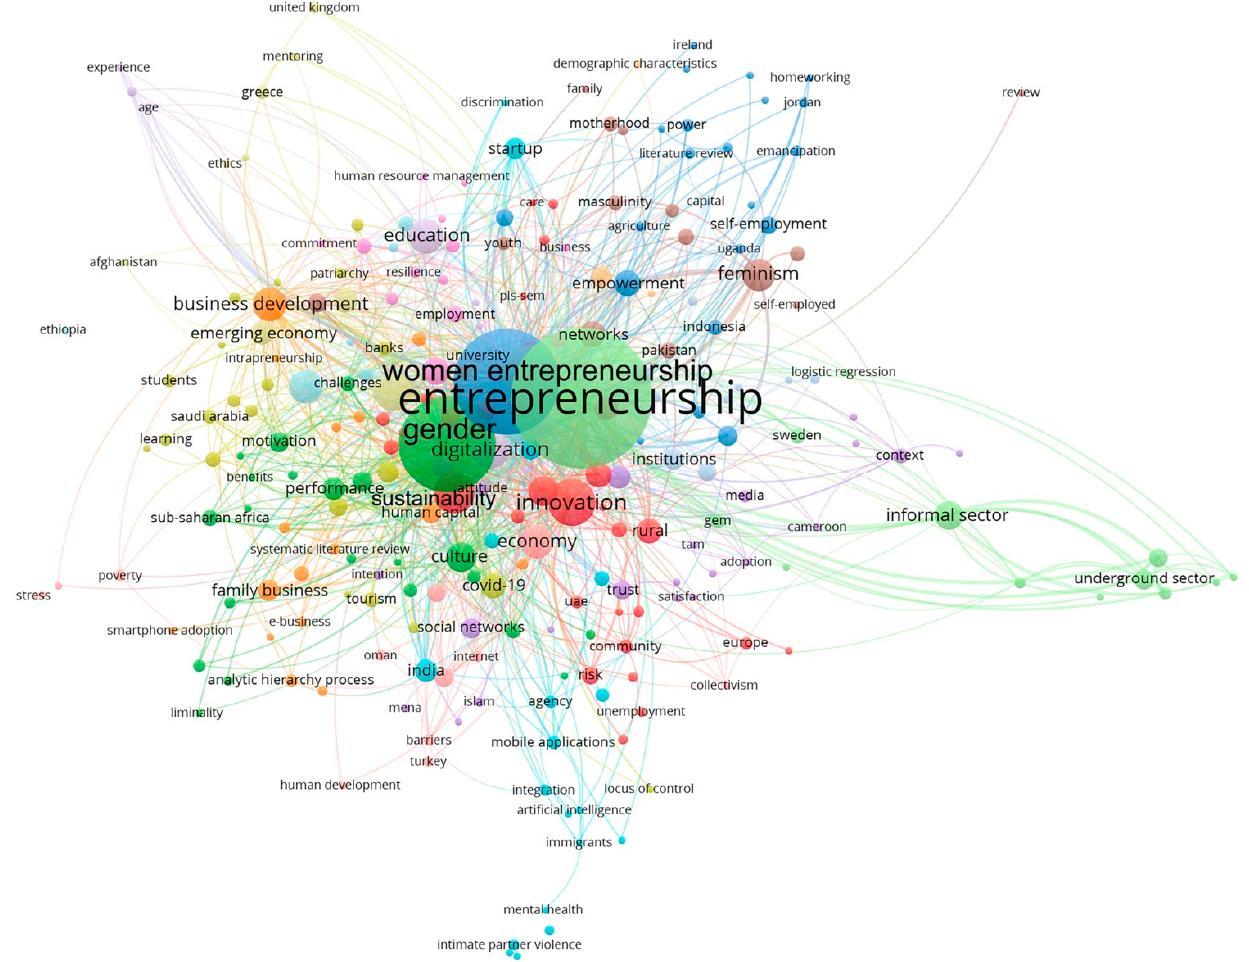
Figure 6. Keyword co-occurrence